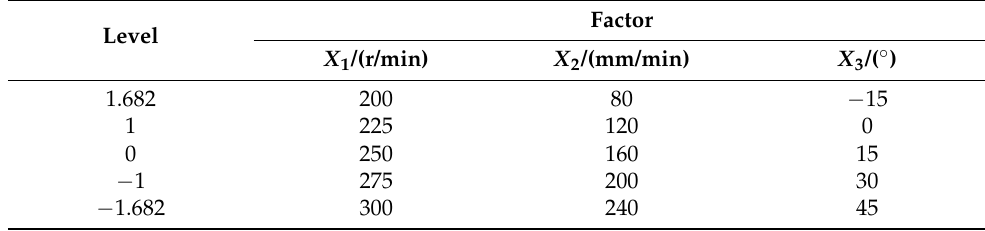
Table 2. End-effector picking performance test factor level coding table.